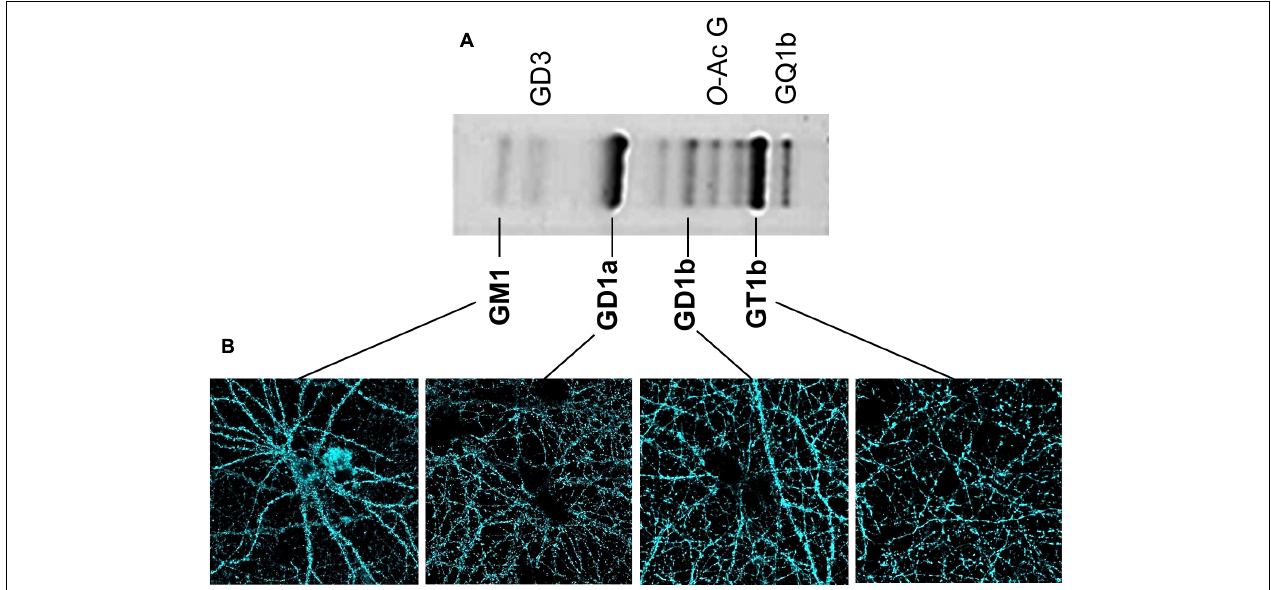
FIGURE 2 | Content of brain gangliosides and visualization of gangliosides in neuronal membrane. (A) Separation of the ganglioside types obtained from homogenates of hippocampal cell membranes was performed using HPTLC as described (Svennerholm, 1963). Briefly, gangliosides were extracted from homogenized tissue using a chloroform/methanol/water mix and then purified using a SPECTRA/POR 6 Dialysis Tubing membrane. After drying, samples were spotted on HPTLC plate developed in chloroform/methanol/CaCl2 mix. Gangliosides were detected with a resorcinol-HCl reagent. The identity of each ganglioside type is indicated. (B) Confocal microscopy and KO-controlled primary monoclonal antibodies (Schnaar et al., 2002) were used to evaluate independent presence of each of the gangliosides GM1, GD1a, GD1b, and GT1b on the cell surface of living hippocampal neurons. Our procedure to stain living neurons in the absence of fixative and detergents has been described (Herrera-Molina et al., 2012, 2014). Briefly, living rat neurons were directly treated with each of the KO-controlled anti-ganglioside monoclonal antibody diluted in culture media (1:500) for 20 min at 37 ◦ C, 5% CO 2 . Then, neurons were carefully washed with culture media, fixed with PFA for 10 min at 37 ◦ C, stained with Alexa 488-conjugated secondary antibodies for 1 h, and mounted with Mowiol. All four gangliosides displayed a specific patched